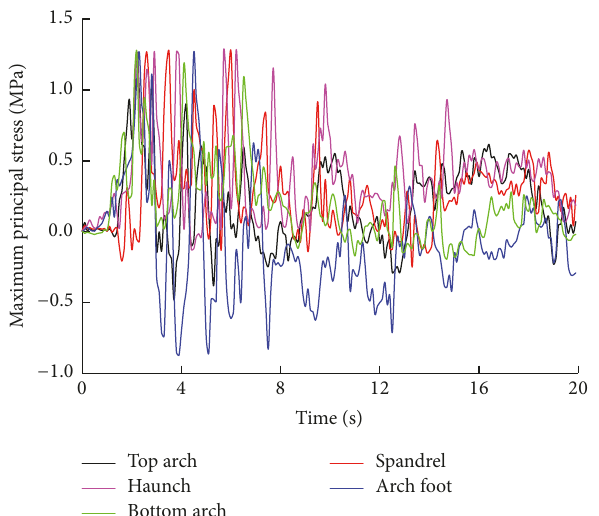
Figure 9: Maximum principal stress time-history of monitoring points.